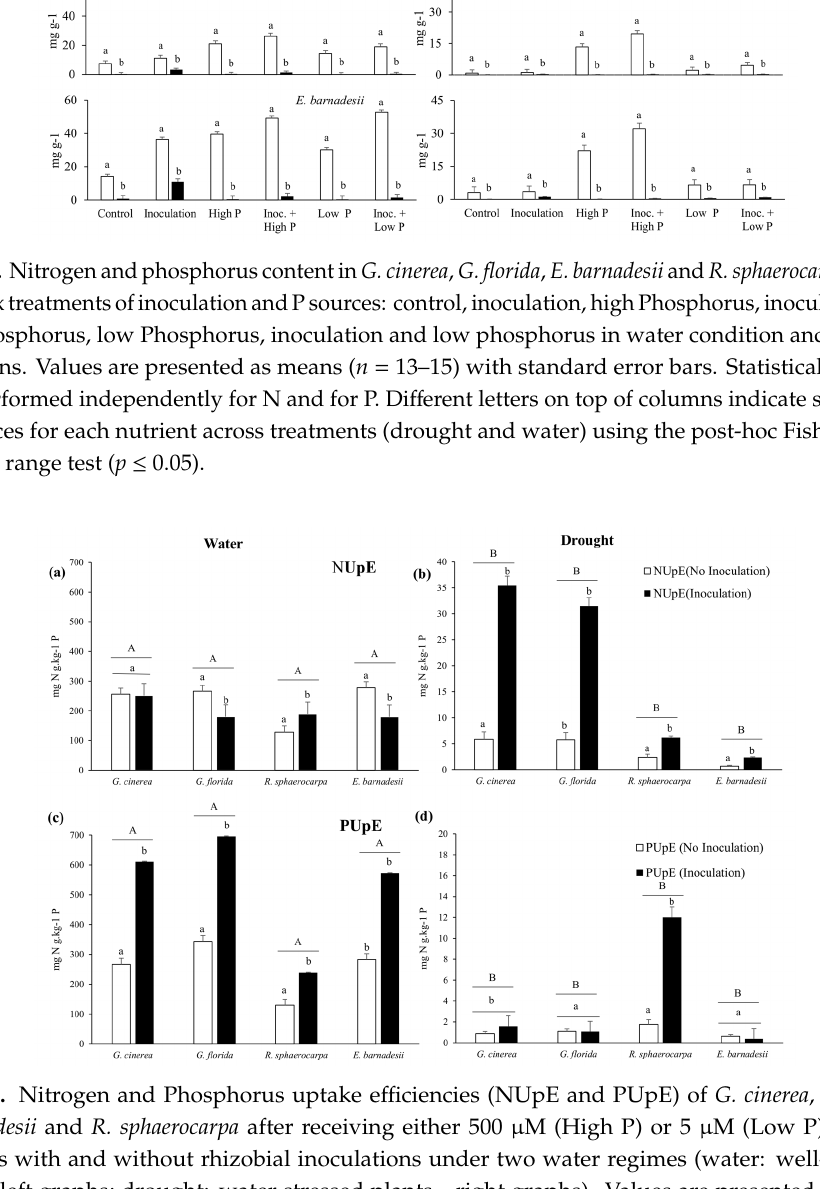
Figure 6. Nitrogen and Phosphorus uptake efficiencies (NUpE and PUpE) of G. cinerea , G. florida , E. barnadesii and R. sphaerocarpa after receiving either 500 µ M (High P) or 5 µ M (Low P) nutrient solutions with and without rhizobial inoculations under two water regimes (water: well-irrigated plants—left graphs; drought: water stressed plants—right graphs). Values are presented as means ( n = 13–15) with standard error bars. Upper case letters indicate significant differences between water treatments, and lower case letters indicate significant differences among inoculation treatments using the post-hoc Fisher’s LSD, multiple range test ( p ≤ 0.05). Note different scales.